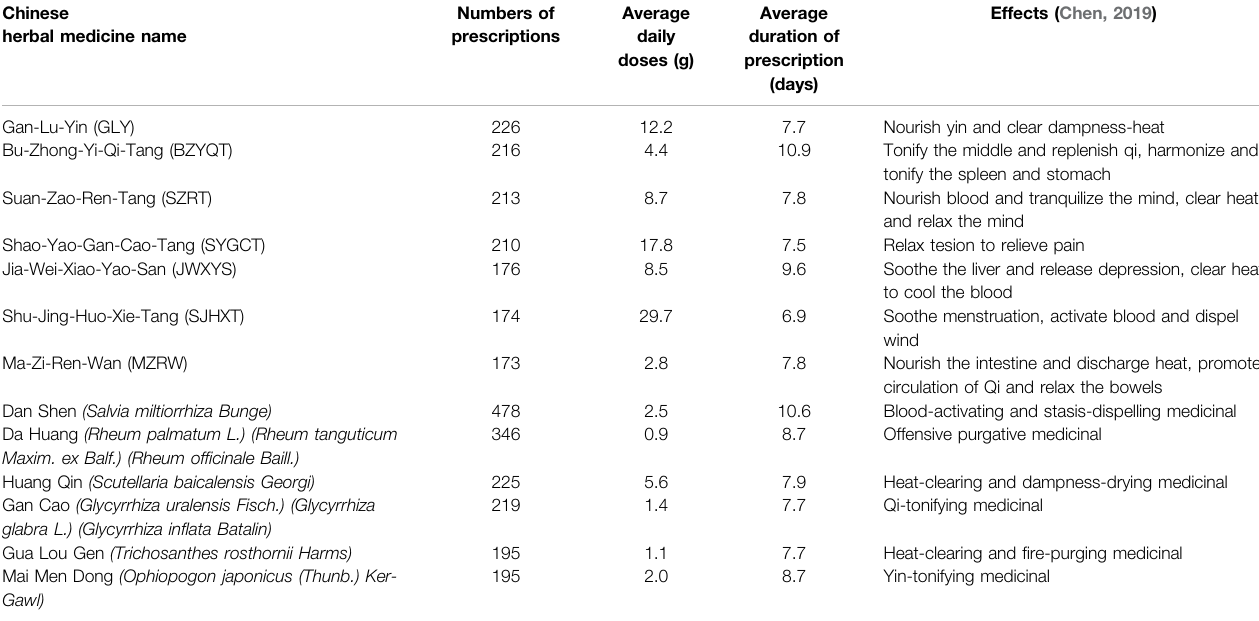
TABLE 2 | Potentially bene fi cial CHMs for ischemic stroke in cancer patients who used chemotherapy between Jan 1, 2000 and Dec 31, 2006, at 5 years of follow-up. Chinese herbal medicine